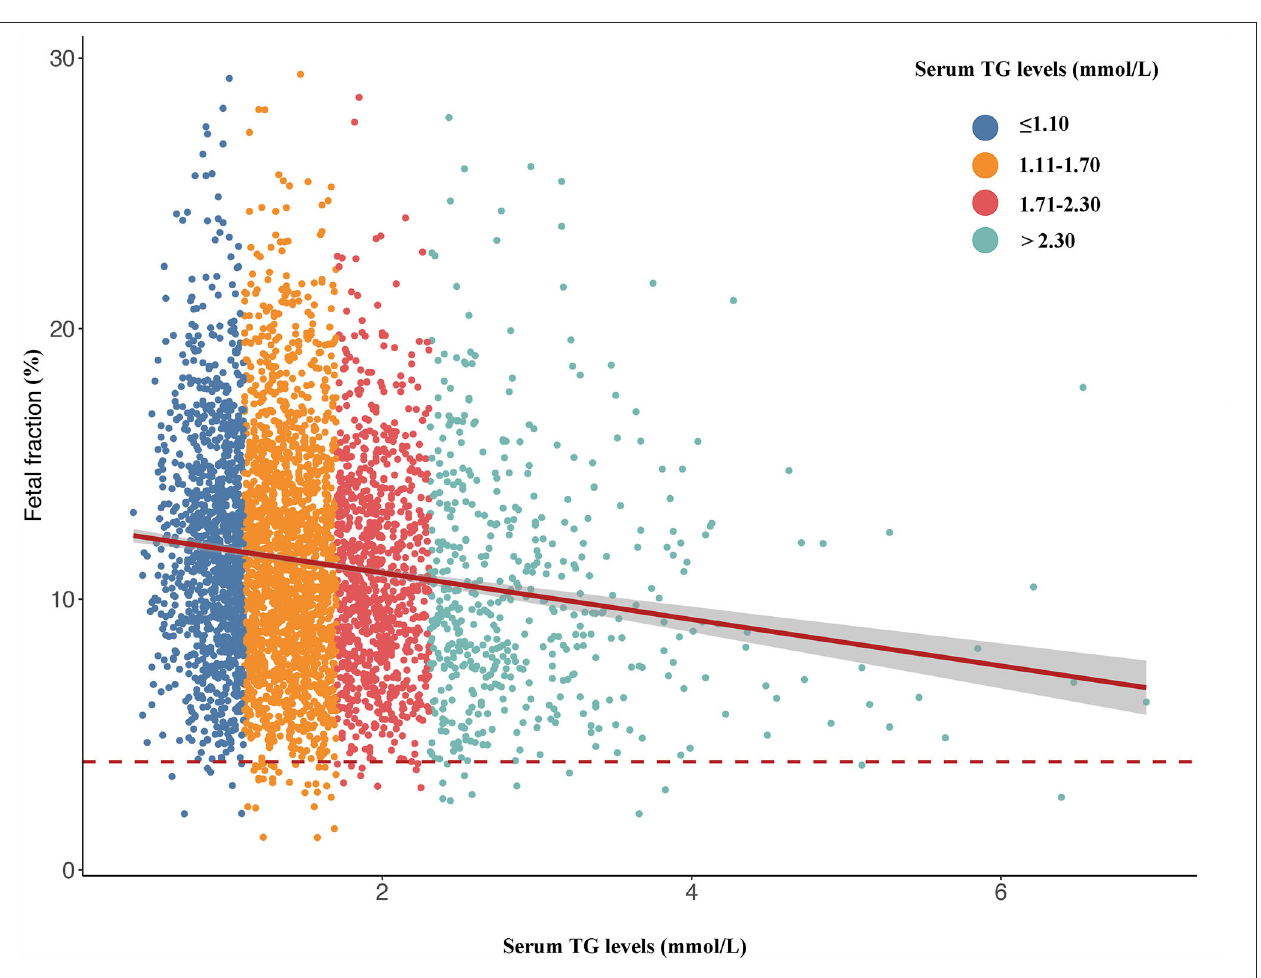
Frontiers in Medicine |